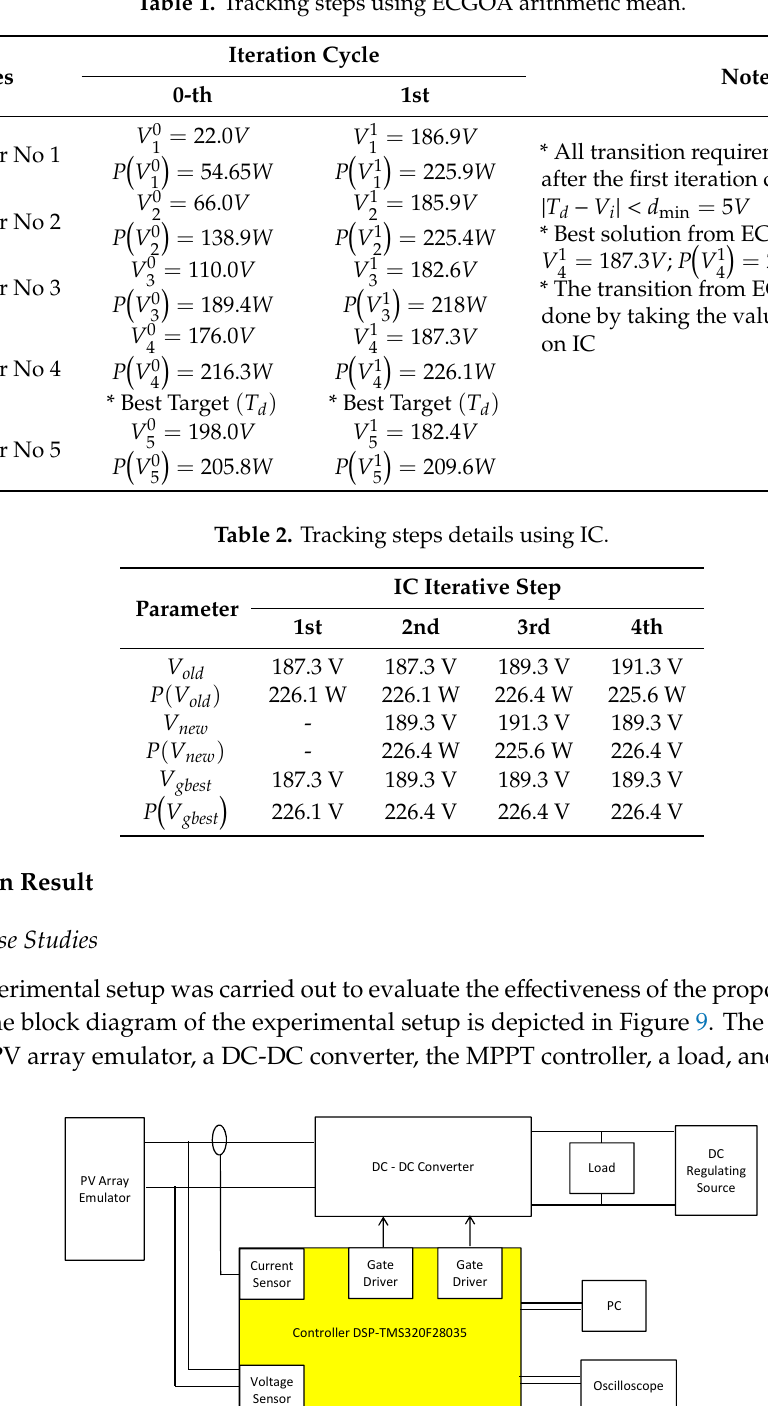
Table 1. Tracking steps using ECGOA arithmetic mean.